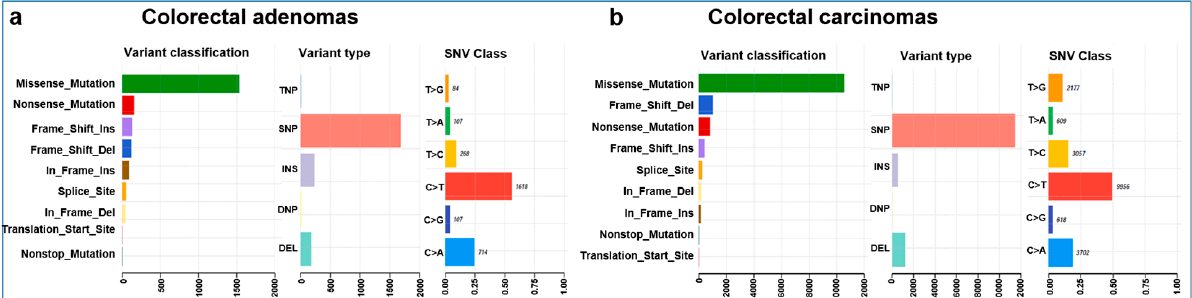
Figure 1. Summary plots of the variants found in colorectal adenomas ( a ) and carcinomas ( b ). Variant classification distribution: the X -axis represents the number of variants, and the Y -axis represents the variant type categories. Variant type plot: the X -axis represents the number of variants, and the Y -axis represents the variant type categories and SNV class plot.